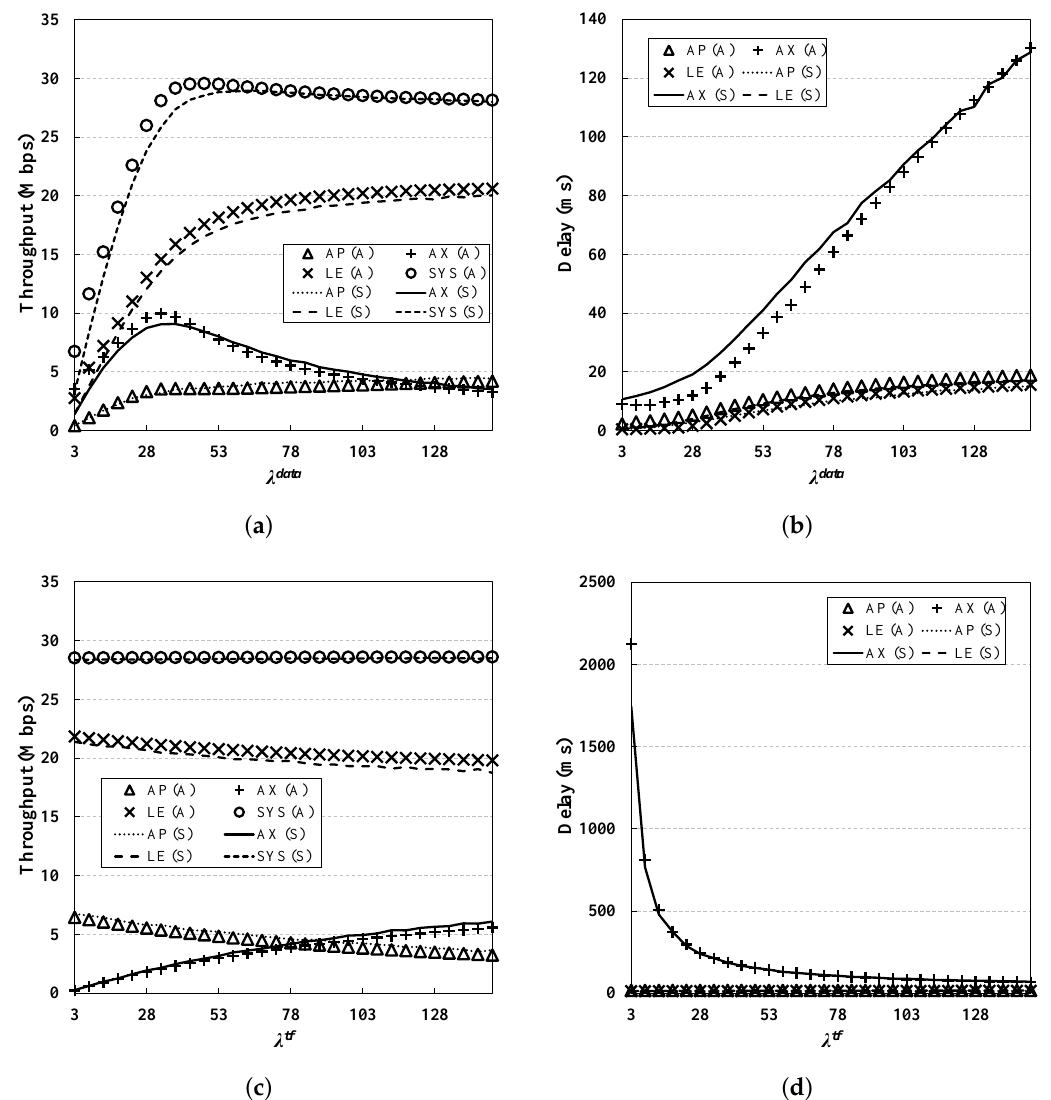
Figure 7. Performance evaluation for different values of λ . The performance of AX STAs is highly affected by λ tf . ( a ) Throughput (varying λ data ); ( b ) Delay (varying λ data ); ( c ) Throughput (varying λ tf ); ( d ) Delay (varying λ tf